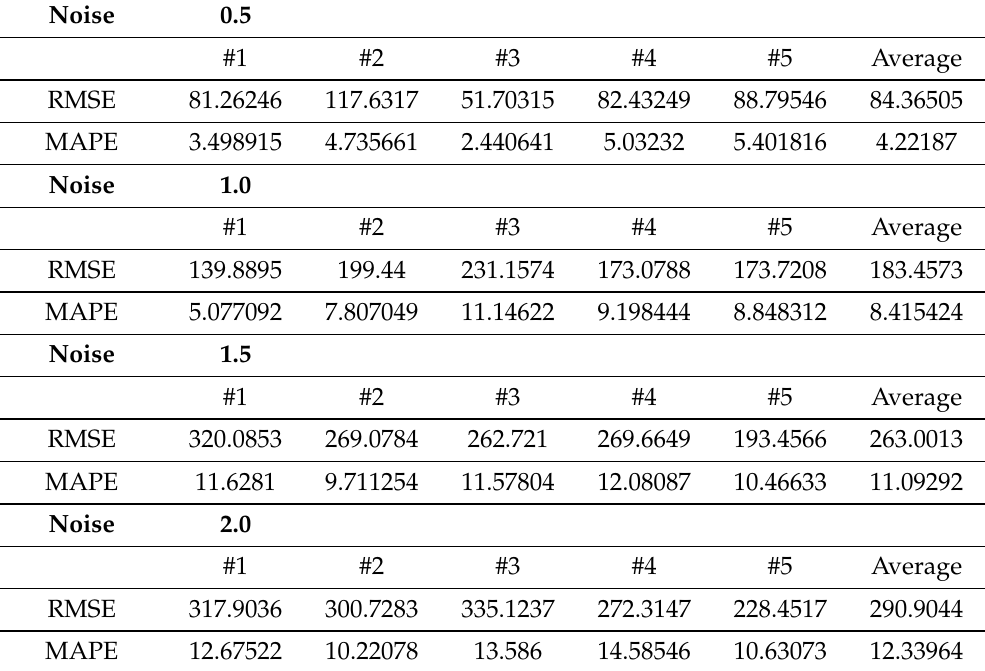
Table 2. Performance of LSTM prediction for random signal.